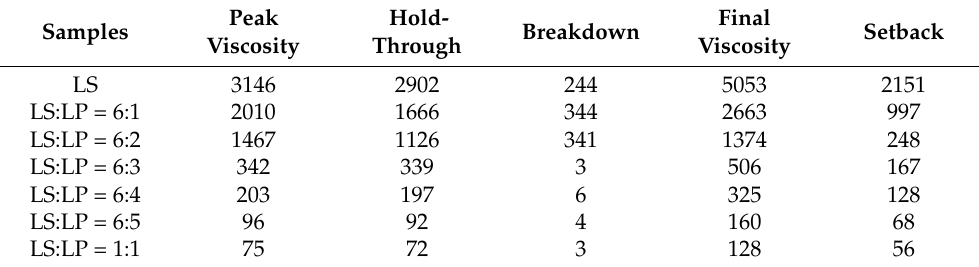
(Note: The figure displayed that lotus seed starch–protein mixture (LS-LP). LS indicates lotus seed starch. LS-LP = 6:1–5 or 1:1 indicates lotus seed starch–protein with different